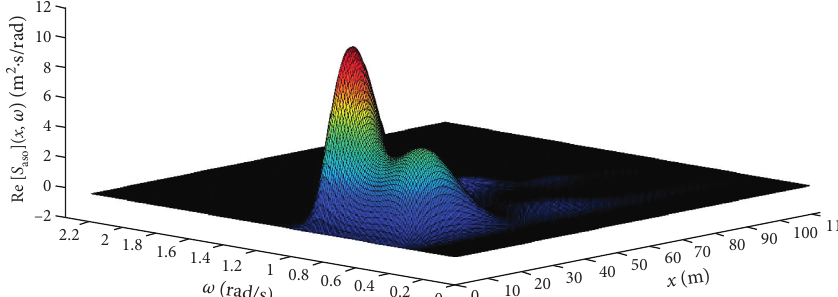
Figure 6: Real part of the stress cross spectrum ( H